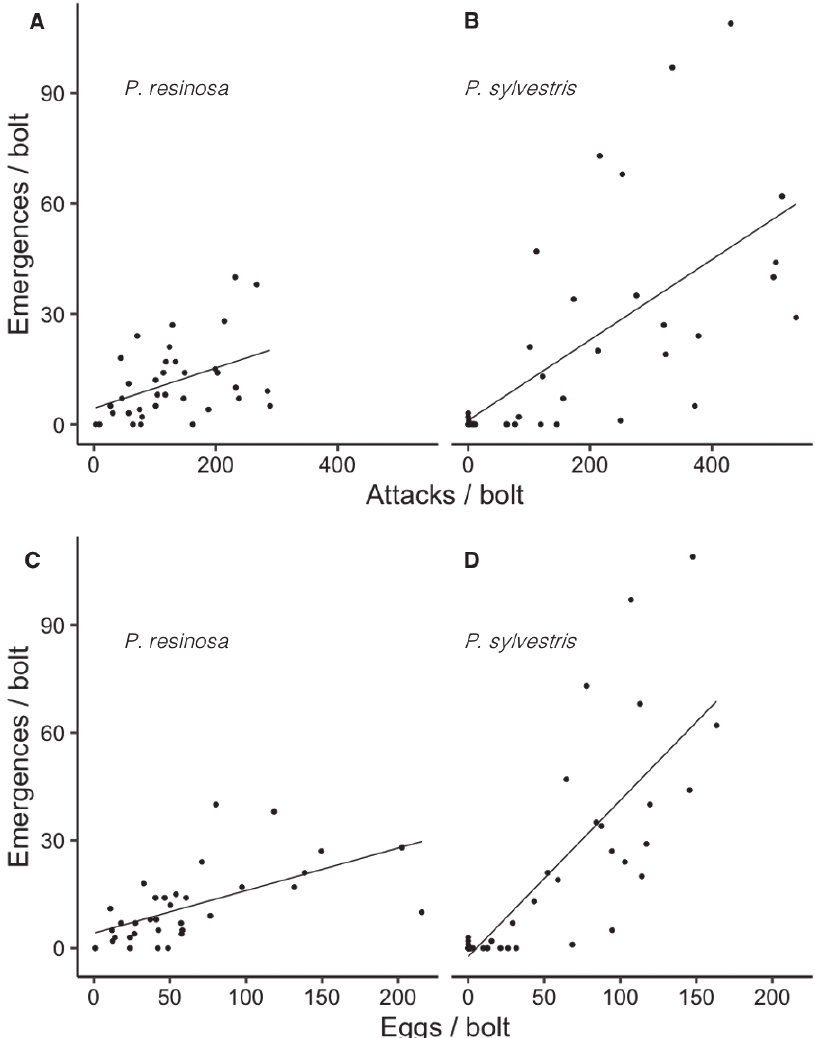
Figure 4. Sirex noctilio emergence success. Emergence per attack for Pinus resinosa ( A slope = 0.08 ± 0.01) and P. sylvestris ( B slope = 0.11 ± 0.01) and emergence per estimated number of eggs laid for P. res- inosa ( C slope = 0.16 ± 0.02) and P. sylvestris ( D slope = 0.41 ± 0.04). Each point represents one